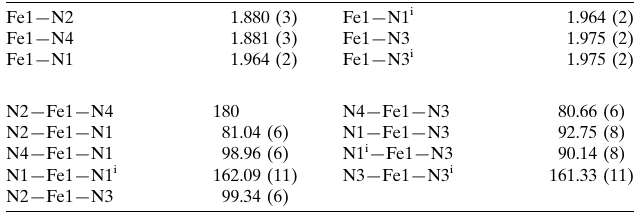
Selected geometric parameters (A˚ , (cid:2) ).